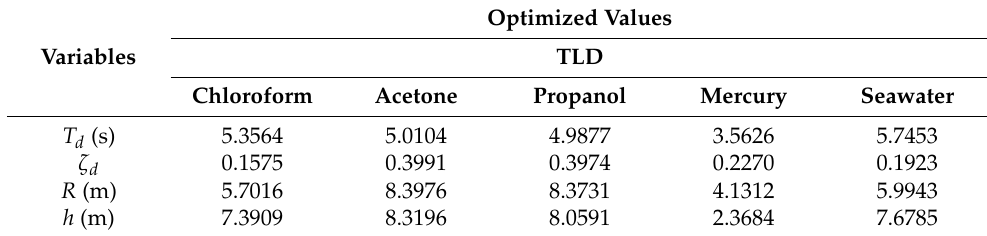
Table 10. TLD + 40 ‐ story building model critical seismic analysis results.